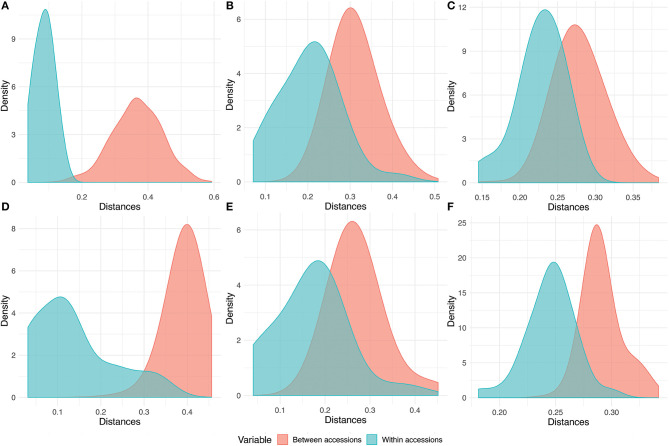
Comparison graph of densities of within and between accession distances. (A–C) denotes the phenotypic distance distribution for sorghum, pigeonpea, and pearl millet, respectively, and (D–F) denotes the genotypic within and between accession distance distribution estimated from DArTSeq-SNP data of sorghum, pigeonpea, and pearl millet, respectively.